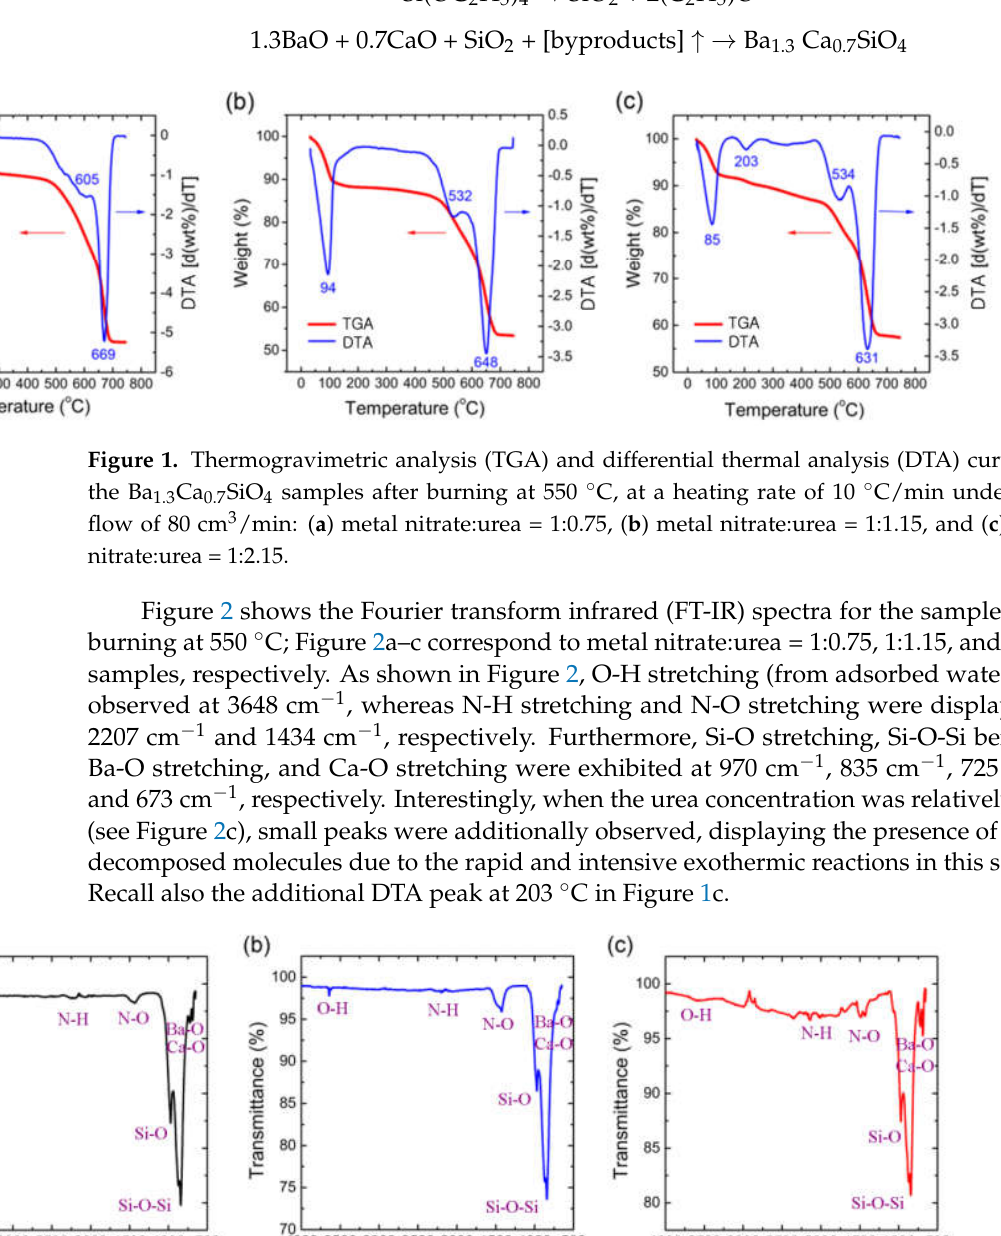
Figure 2. FTIR spectra of Ba 1.3 Ca 0.7 SiO 4 samples burned at 550 °C: ( a ) metal nitrate:urea = 1:0.75, ( b ) metal nitrate:urea = 1:1.15, and ( c ) metal nitrate:urea = 1:2.15.